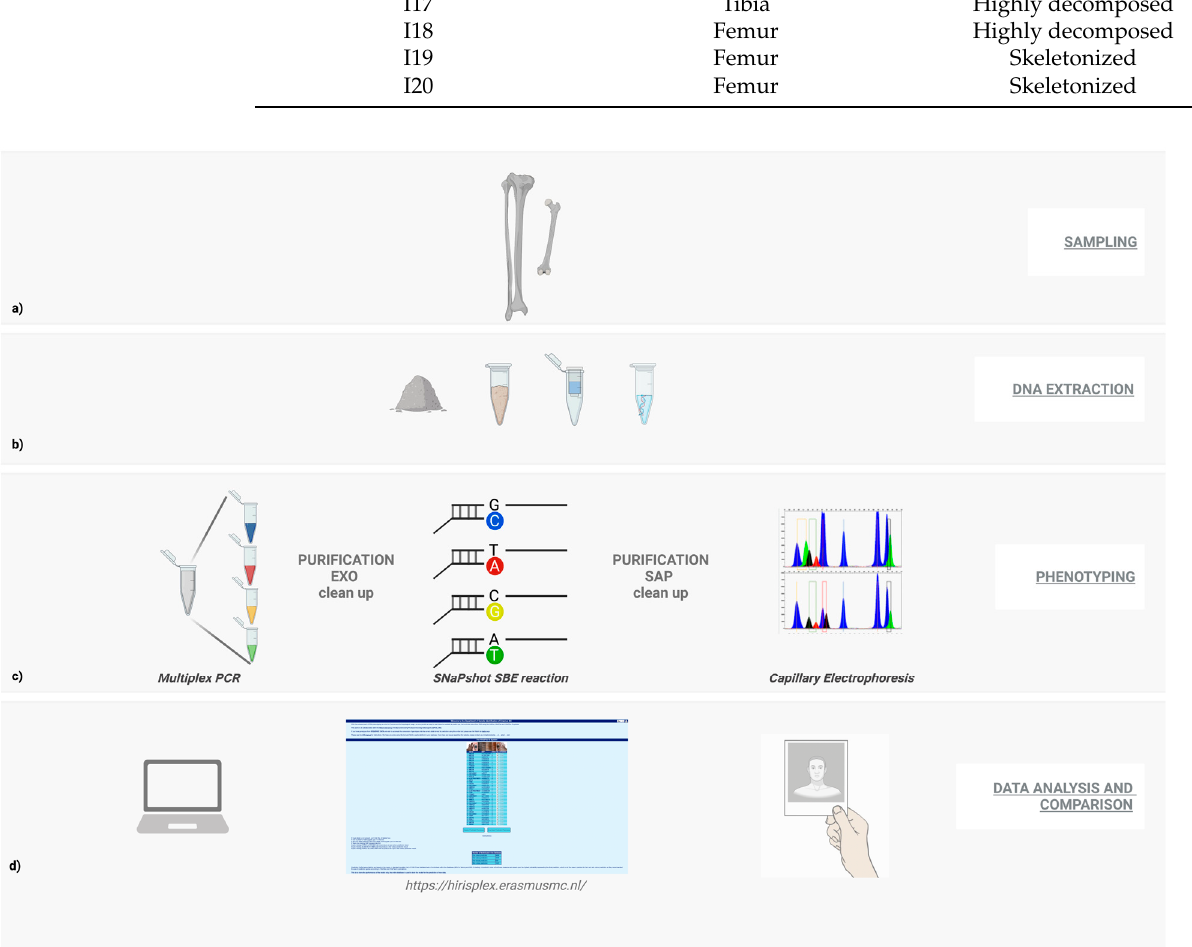
Figure 1. Illustration of the workflow for multiplex PCR phenotyping. Outlining of the main work steps: ( a ) sampling, ( b ) gDNA extraction, ( c ) multiplex PCR, purification of amplicons with exonu- clease, SBE reactions, enzymatic purification with SAP, capillary electrophoresis, ( d ) integration of genetic data in the on-line table to obtain phenotypic results, and finally, comparison of these with the photograms of the